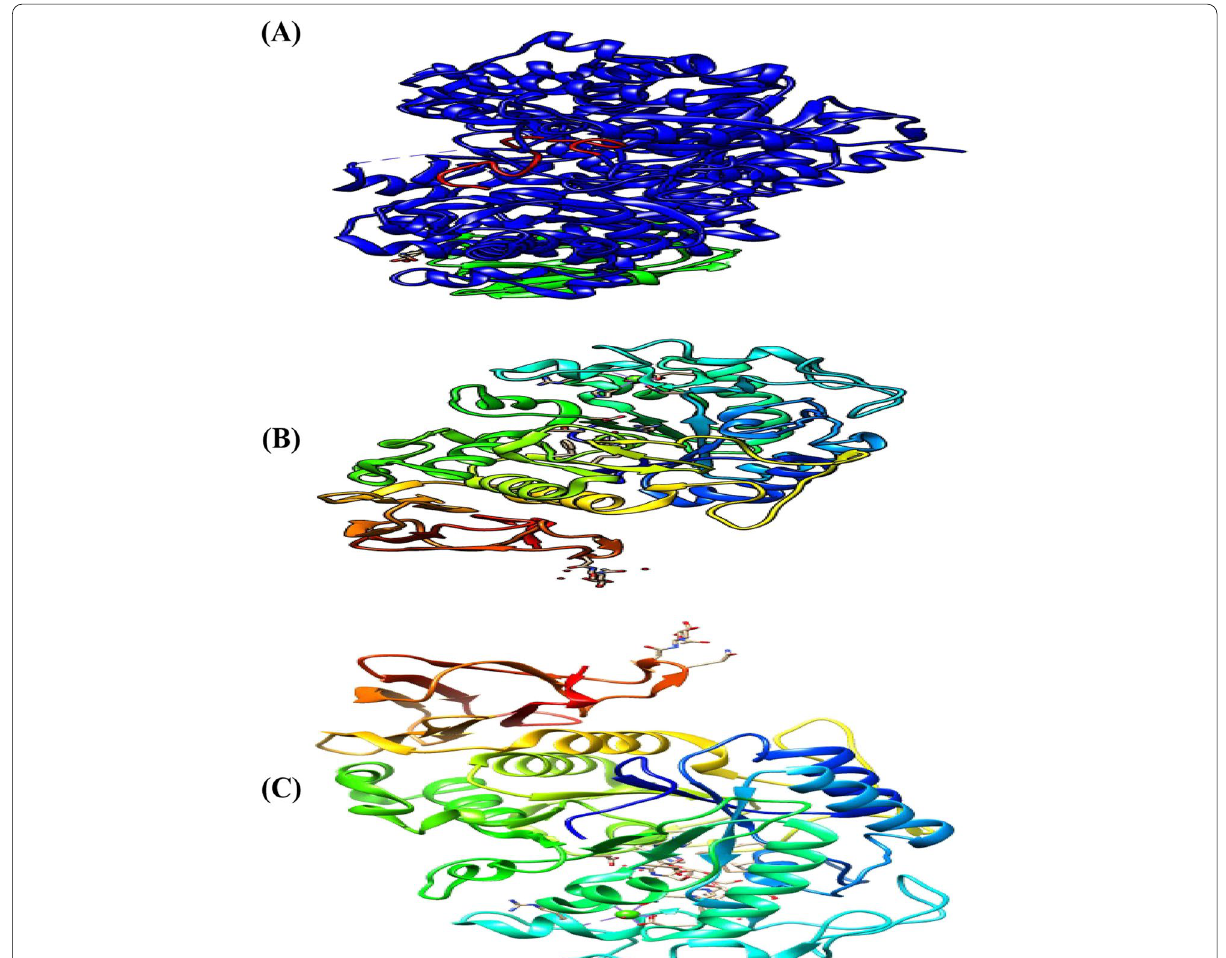
Fig. 1 The 3D crystal structure of target proteins displayed UCSF Chimera. (A) . FGF-21. (B) . Pancreatic α-amylase. (C) . Pancreatic α-glucosidase